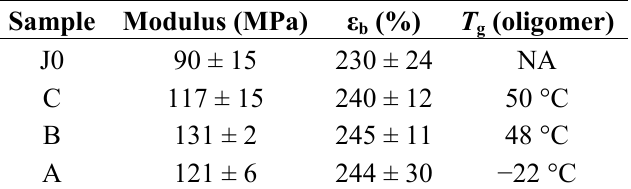
Table 7. Mechanical